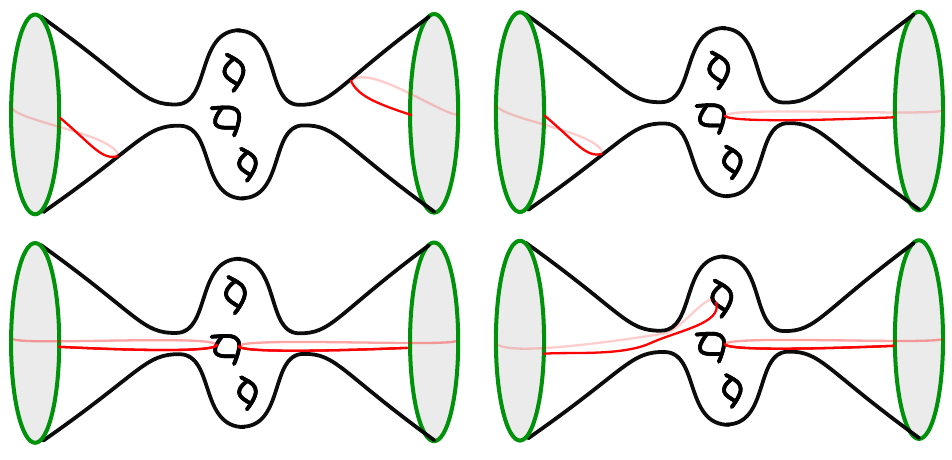
⊕ M h ⊕ M g − h with h 1 , 2 ≥ 0 and 1 , 1 2 , 1 1 − h 2 , 2